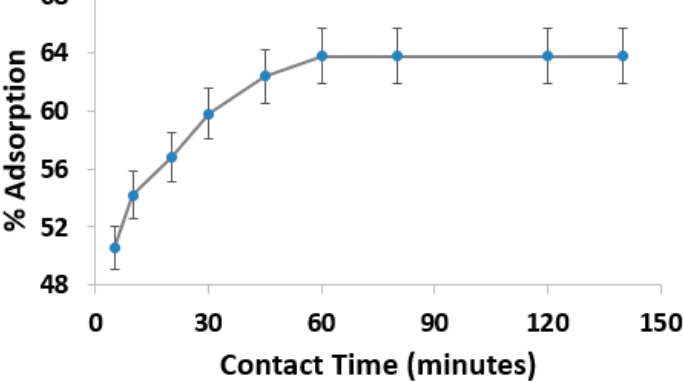
Figure 4. Effect of contact time on the percentage of As (III) adsorption. Error bars represent the standard error from triplicate experiments.